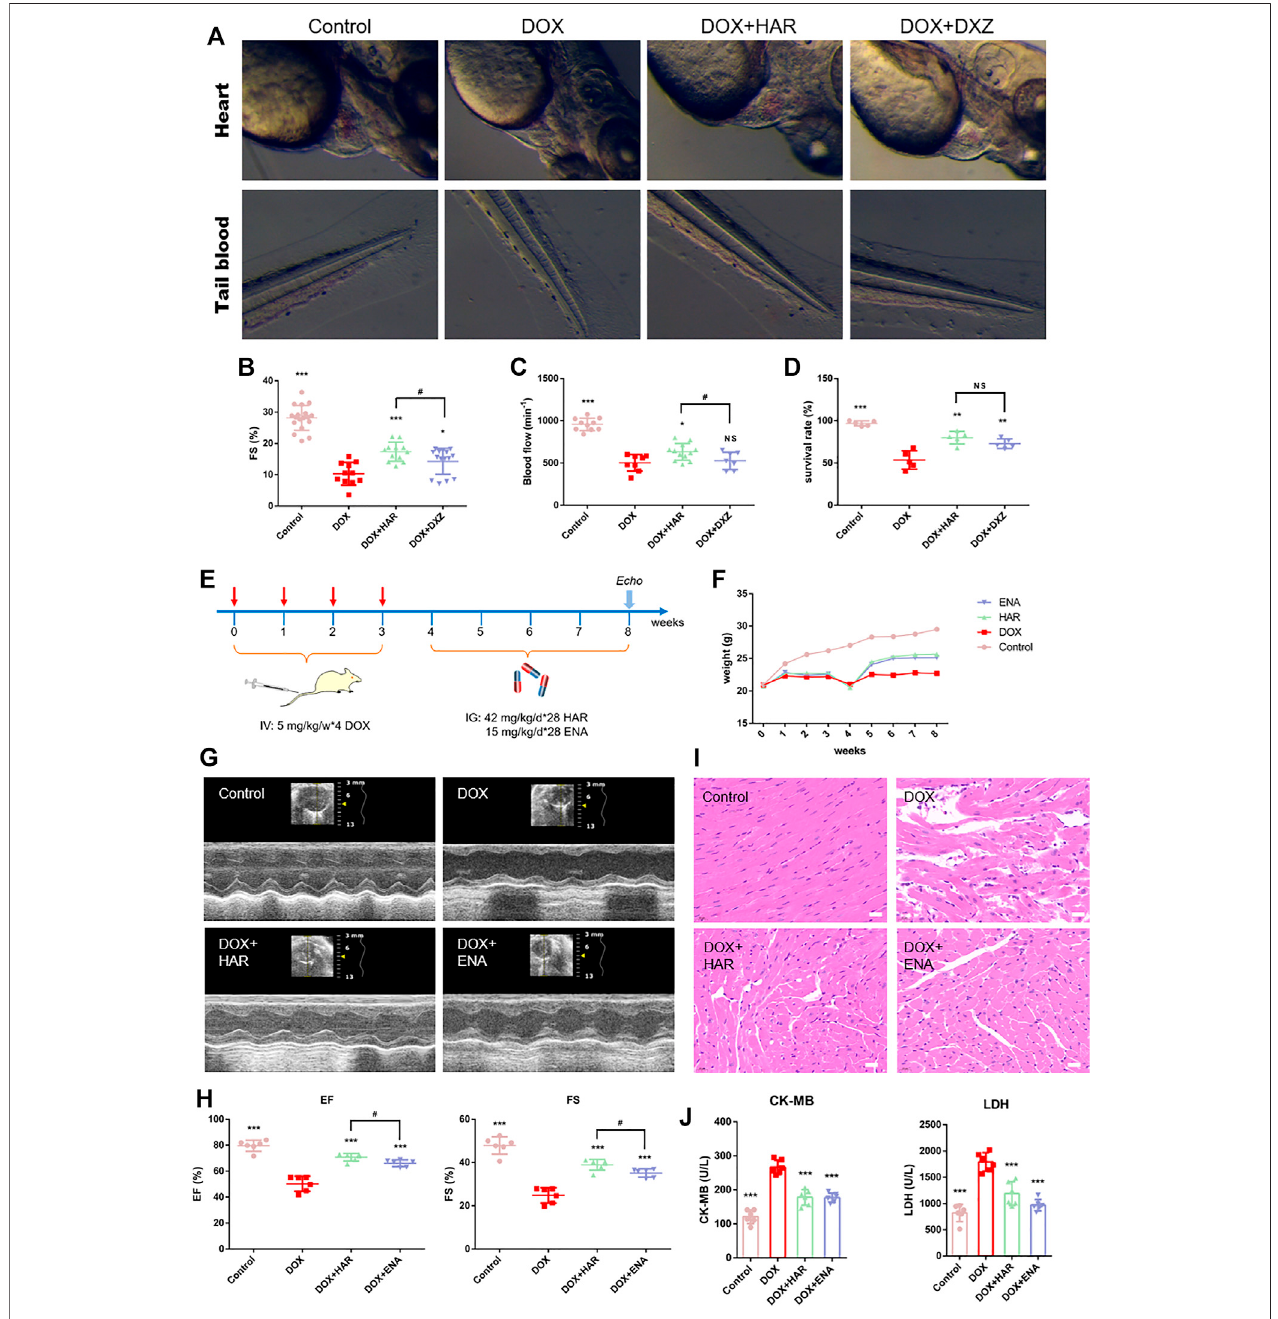
FIGURE1| ProtectiveeffectsofHARonDICTzebra fi shandmice. (A) Representativeimagesofzebra fi shheartandtailblood fl owcapturedbyhigh-speedcamera. (B,C) Quantitative analysis of fractional shortening (FS) value of zebra fi sh hearts and blood fl ow of zebra fi sh tail. (D) Assessment of survival rate of zebra fi sh under different drug treatment. (E) A schematic diagram of animal model generation and drug administration. (F) Body weight changes in various groups ( n = 10). (G) Representative images of echocardiograms. (H) Left ventricular ejection fraction and fractional shortening ( n = 6). (I) Representative images of morphological and structural changes in the myocardium detected by H&E staining. Scale bar: 20 μ m. (J) The content of serum CK-MB and LDH ( n = 6). *** p < 0.001 vs. DOX group. # p < 0.05 vs. (DOX + HAR) group. The data are shown as the mean ± s.d.